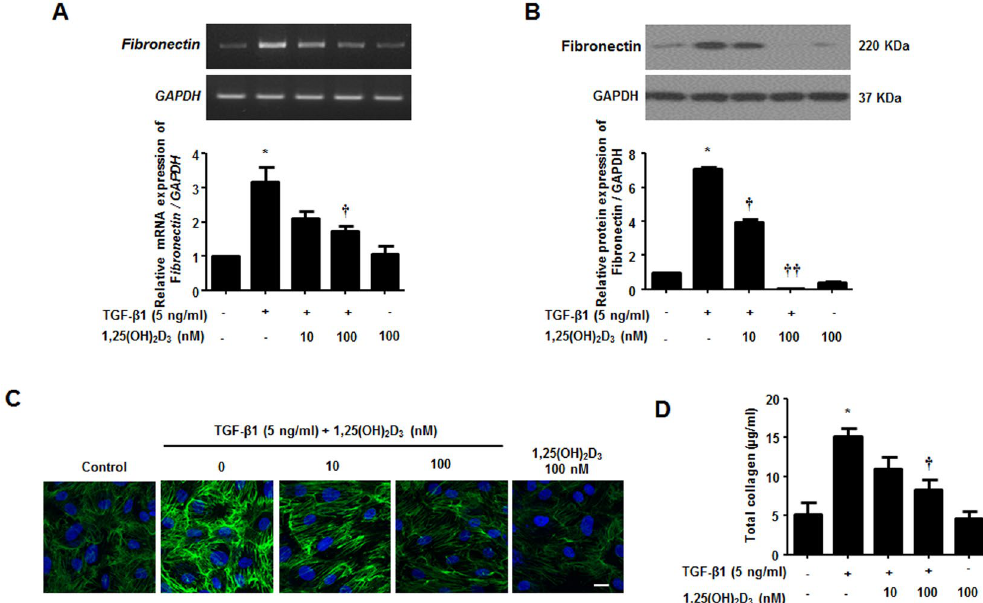
Figure 2. 1,25(OH) 2 D 3 decreases TGF- β 1-induced collagen production in nasal polyp-derived fibroblasts. Nasal polyp-derived fibroblasts were treated with TGF- β 1 and/or 1,25(OH) 2 D 3 or 1,25(OH) 2 D 3 alone for 72 hours. ( A , B ) Expression levels of fibronectin mRNA and protein were determined by semi-quantitative RT-PCR analysis and Western blot analysis. Expression levels of housekeeping GAPDH mRNA and protein were utilized as internal controls. A representative experiment and quantitative determination of fibronectin mRNA and protein levels are shown. ( C ) Representative fluorescein immunocytochemistry for fibronectin (green) with nuclear DAPI (blue). Scale bar = 50 μ m. ( D ) The amount of total soluble collagen in culture media was quantified by the Sircol collagen assay. All data are presented as mean ± SEM. Four primary cell lines from different donors were used. All experiments were performed in at least triplicate and repeated at least three